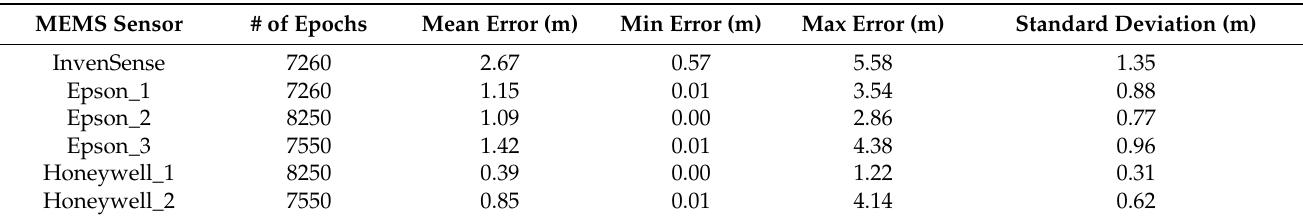
Table 2. Three-dimensional trajectory difference statistics computed in a local level frame with respect to the Honeywell LASEREF V Micro Inertial Reference System (μIRS) reference trajectory.